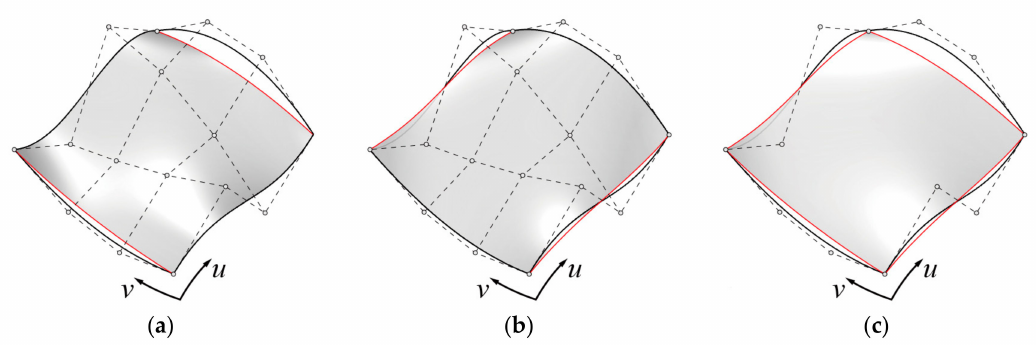
Figure 2. In order to generate the shape-adjustable surface proposed in this paper, three special surfaces are constructed: ( a ) The surface R 1 of B é zier basis functions in its u -direction and CE-B é zier basis functions in its v -direction; ( b ) The surface R 2 of CE-B é zier basis functions in its u -direction and B é zier basis functions in its v -direction; ( c ) The Coons surface S constructed by four CE-B é zier curves.